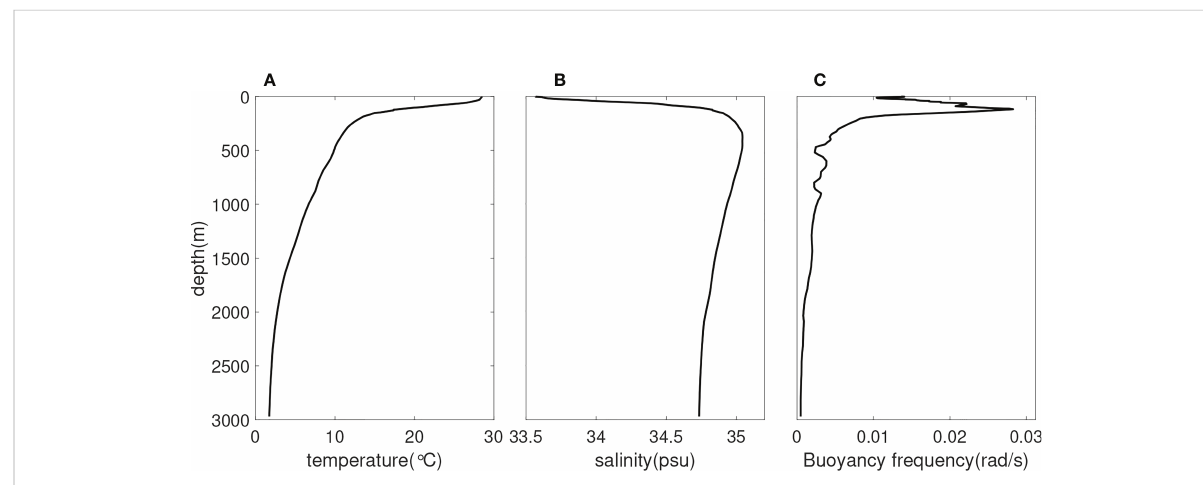
FIGURE 2 Vertical pro fi les of initial (A) temperature, (B) salinity, and (C) buoyancy